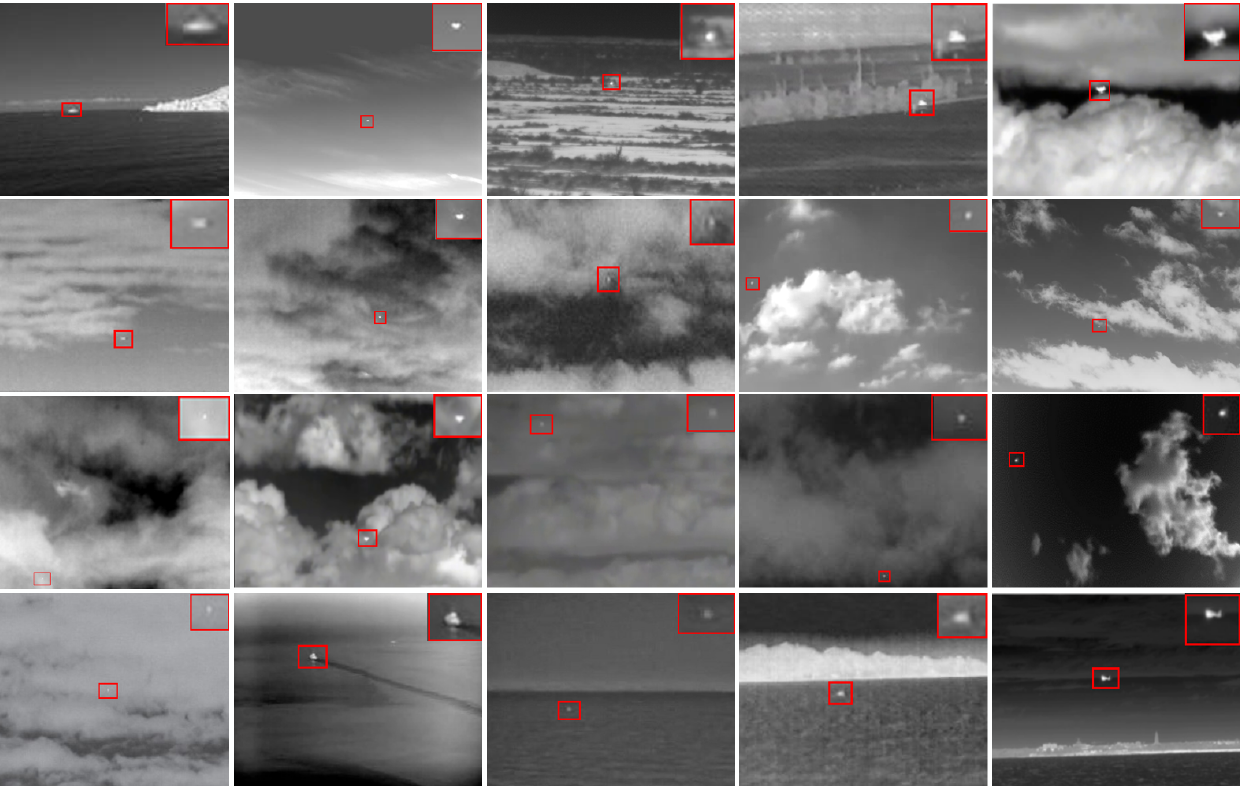
Figure 8. Twenty single-frame images in different